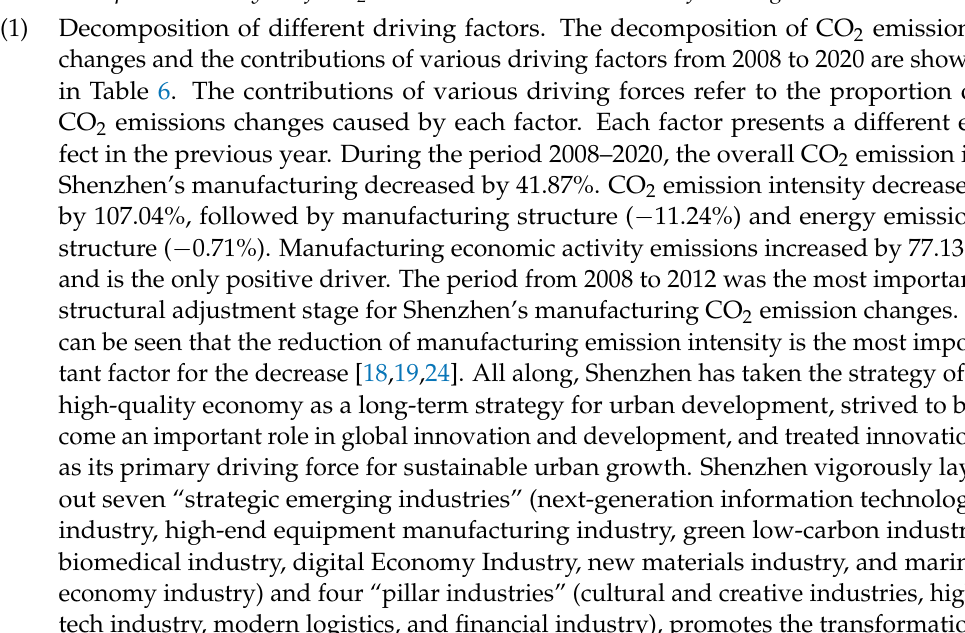
Decomposition of different driving factors. The decomposition of CO 2